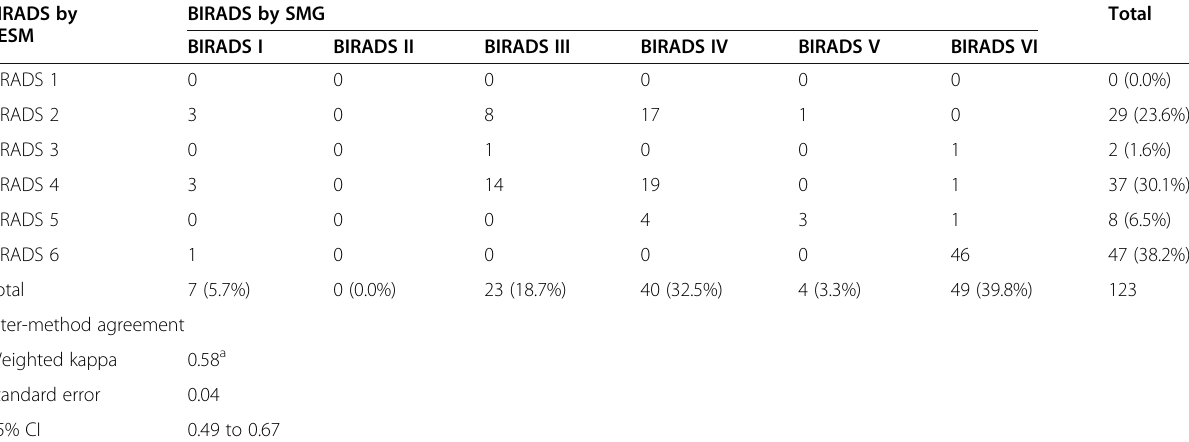
Table 10 Agreement between SMG and CESM as regards the BIRADS classification in the whole study population BIRADS by